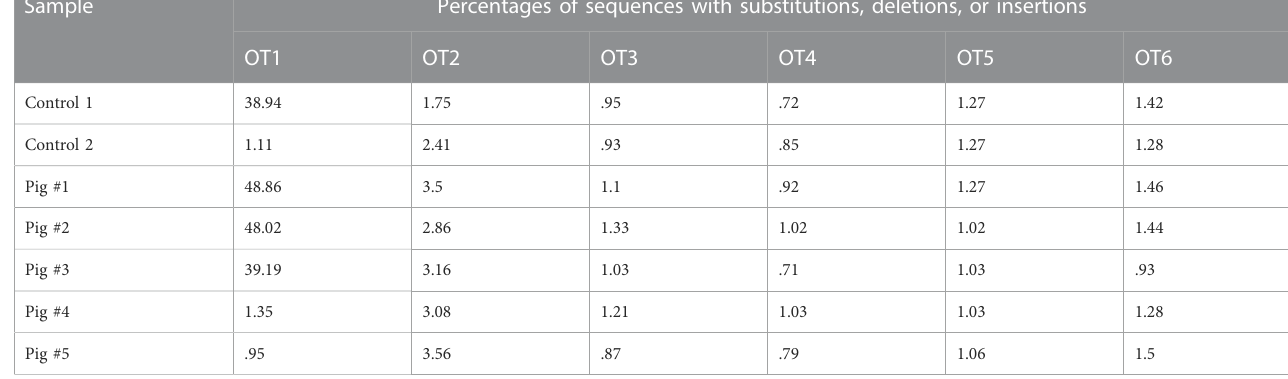
TABLE 1 Frequencies of the mutant sequence at potential off-target sites analyzed using deep sequencing*.